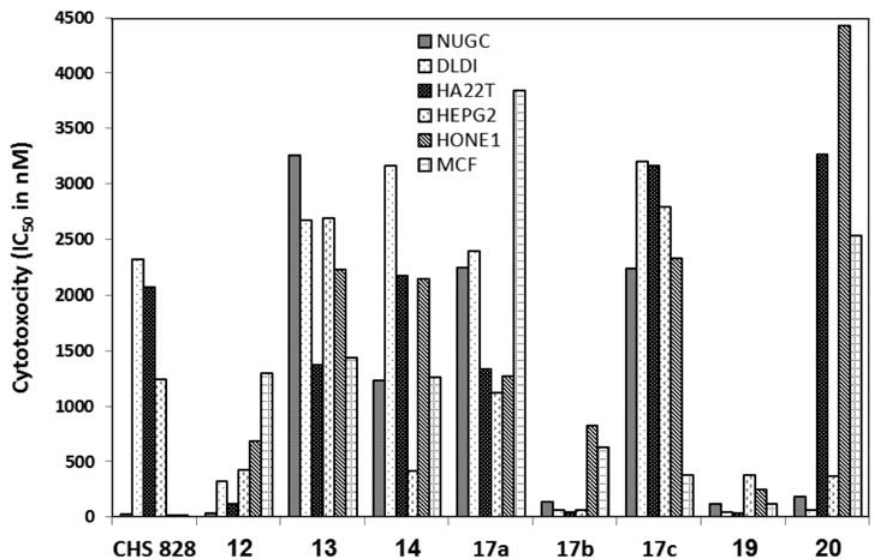
Figure 3 . Cytotoxicity of compounds 12 , 13 , 14 , 17a – c , 19 , 20 and CHS 828 against NUGC (gastric cancer); DLDI (colon cancer); HA22T and HEPG2 (liver cancer); HONE1 (nasopharyngeal carcinoma); MCF (breast